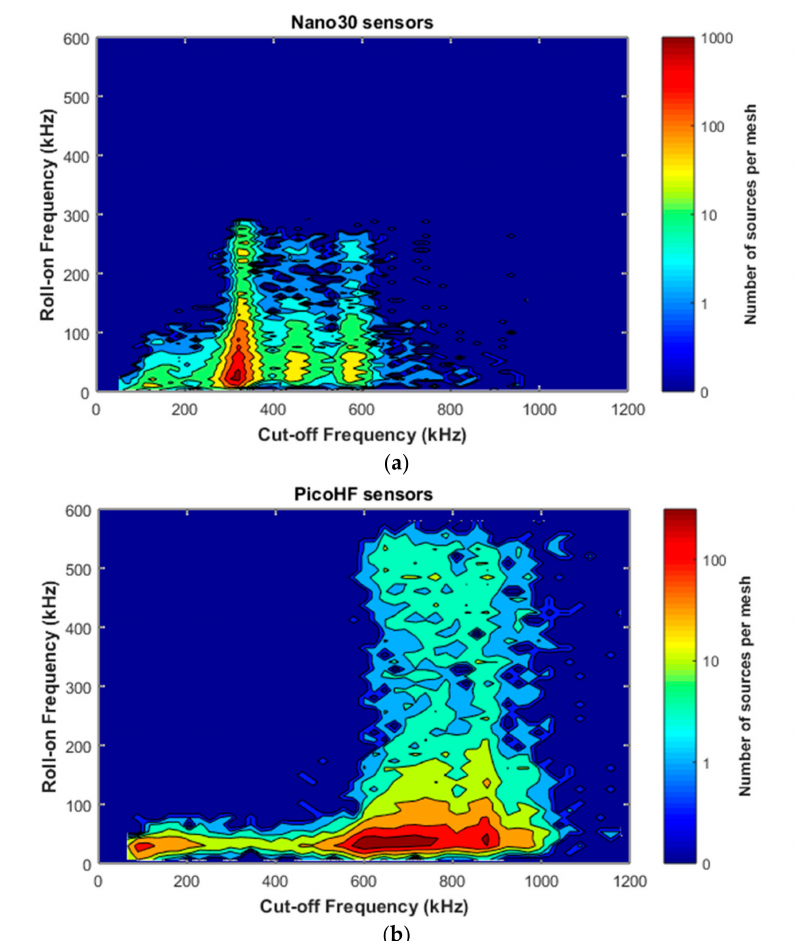
Figure 14. Representation of acoustic emission signals in the plane opening frequency and cut-o ff frequency; ( a ) Nano30 sensors, ( b ) PicoHF sensors—signals recorded during macroscopic tensile test in fiber